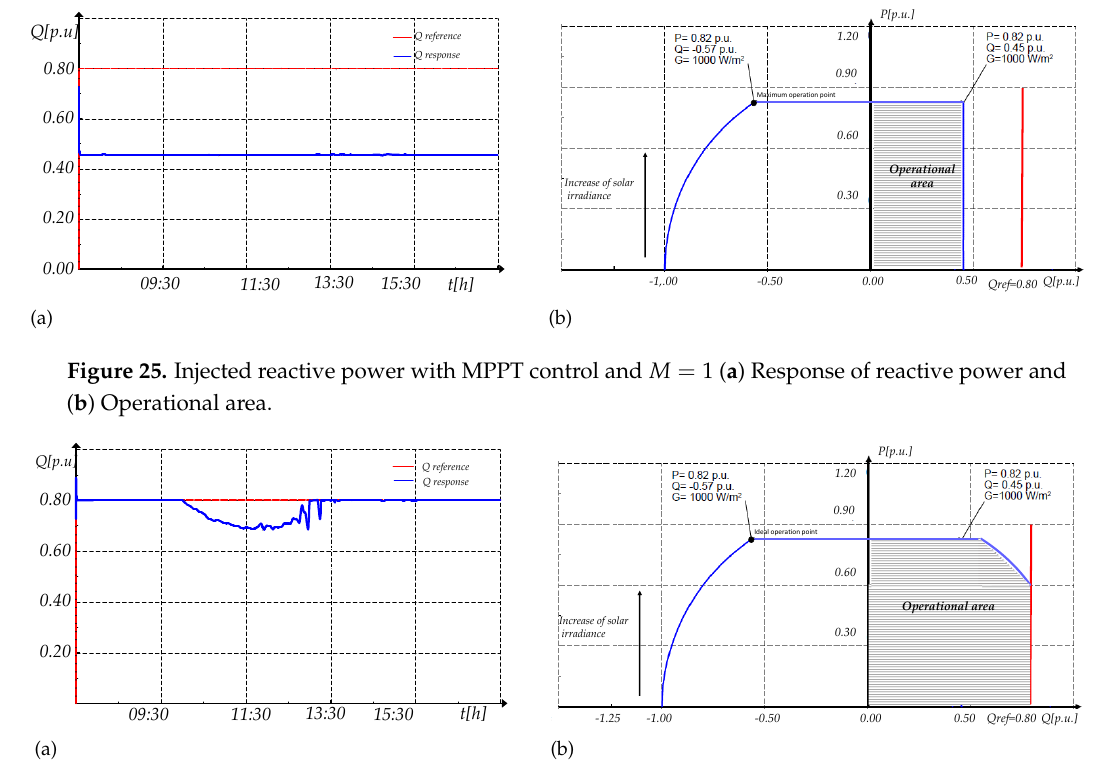
Figure 26. Injected reactive power with MPPT control and M = 1.75 ( a ) Response of reactive power and ( b ) Operational